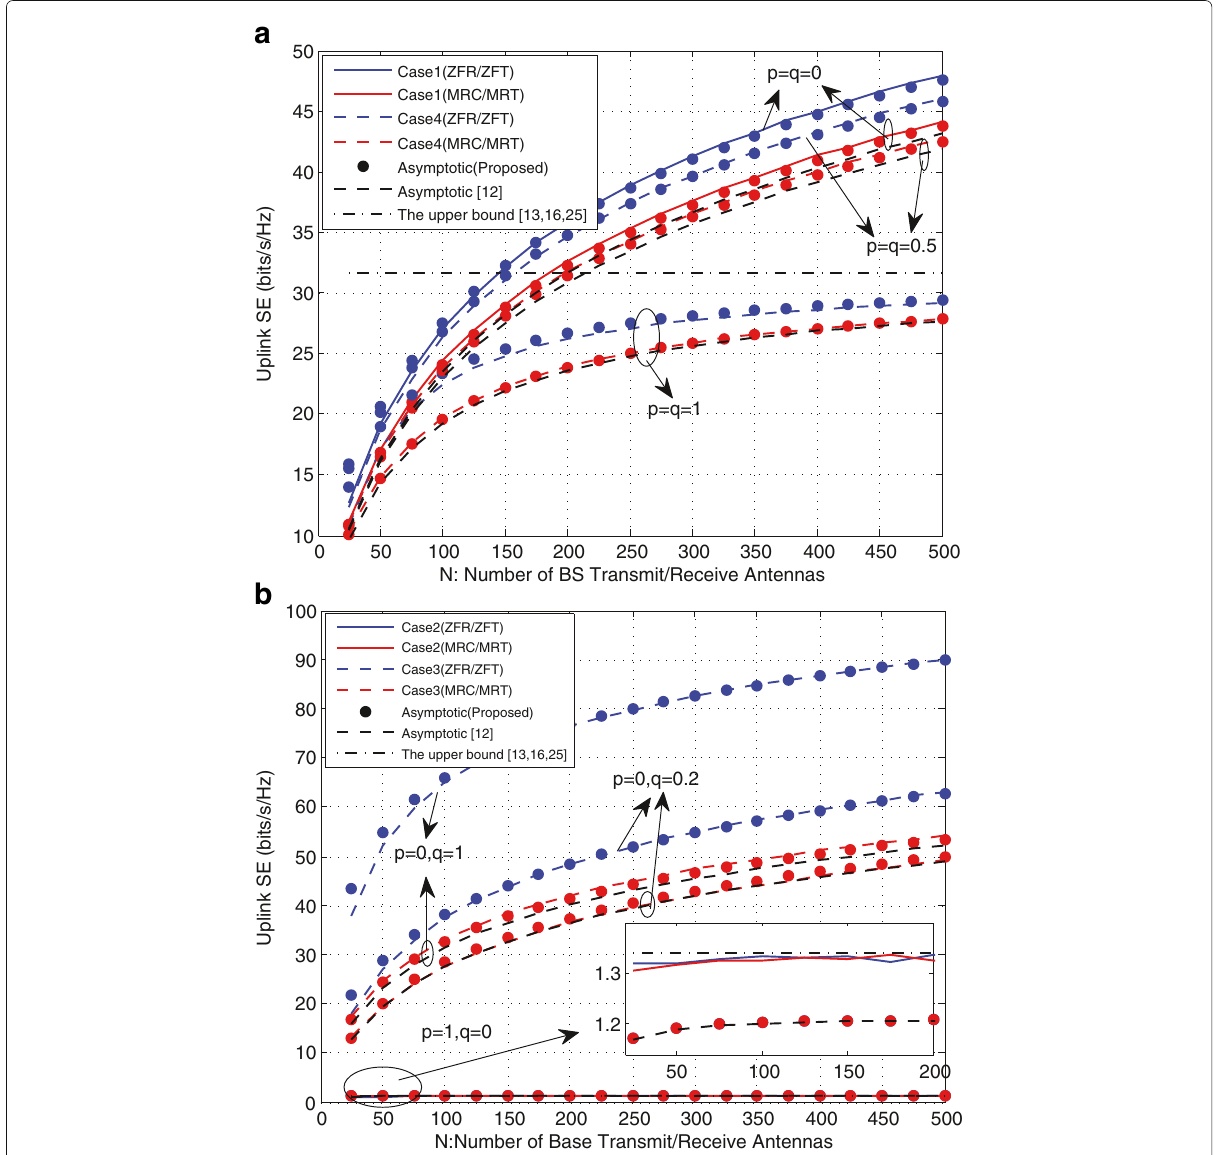
Fig. 2 a Uplink SE for cases 1 and 4. b Uplink SE for cases 2 and 3. Comparison of uplink SE for four schemes versus N with E U = 10 dB, E D = KE U , P P = 0 dB, and β LI = 0